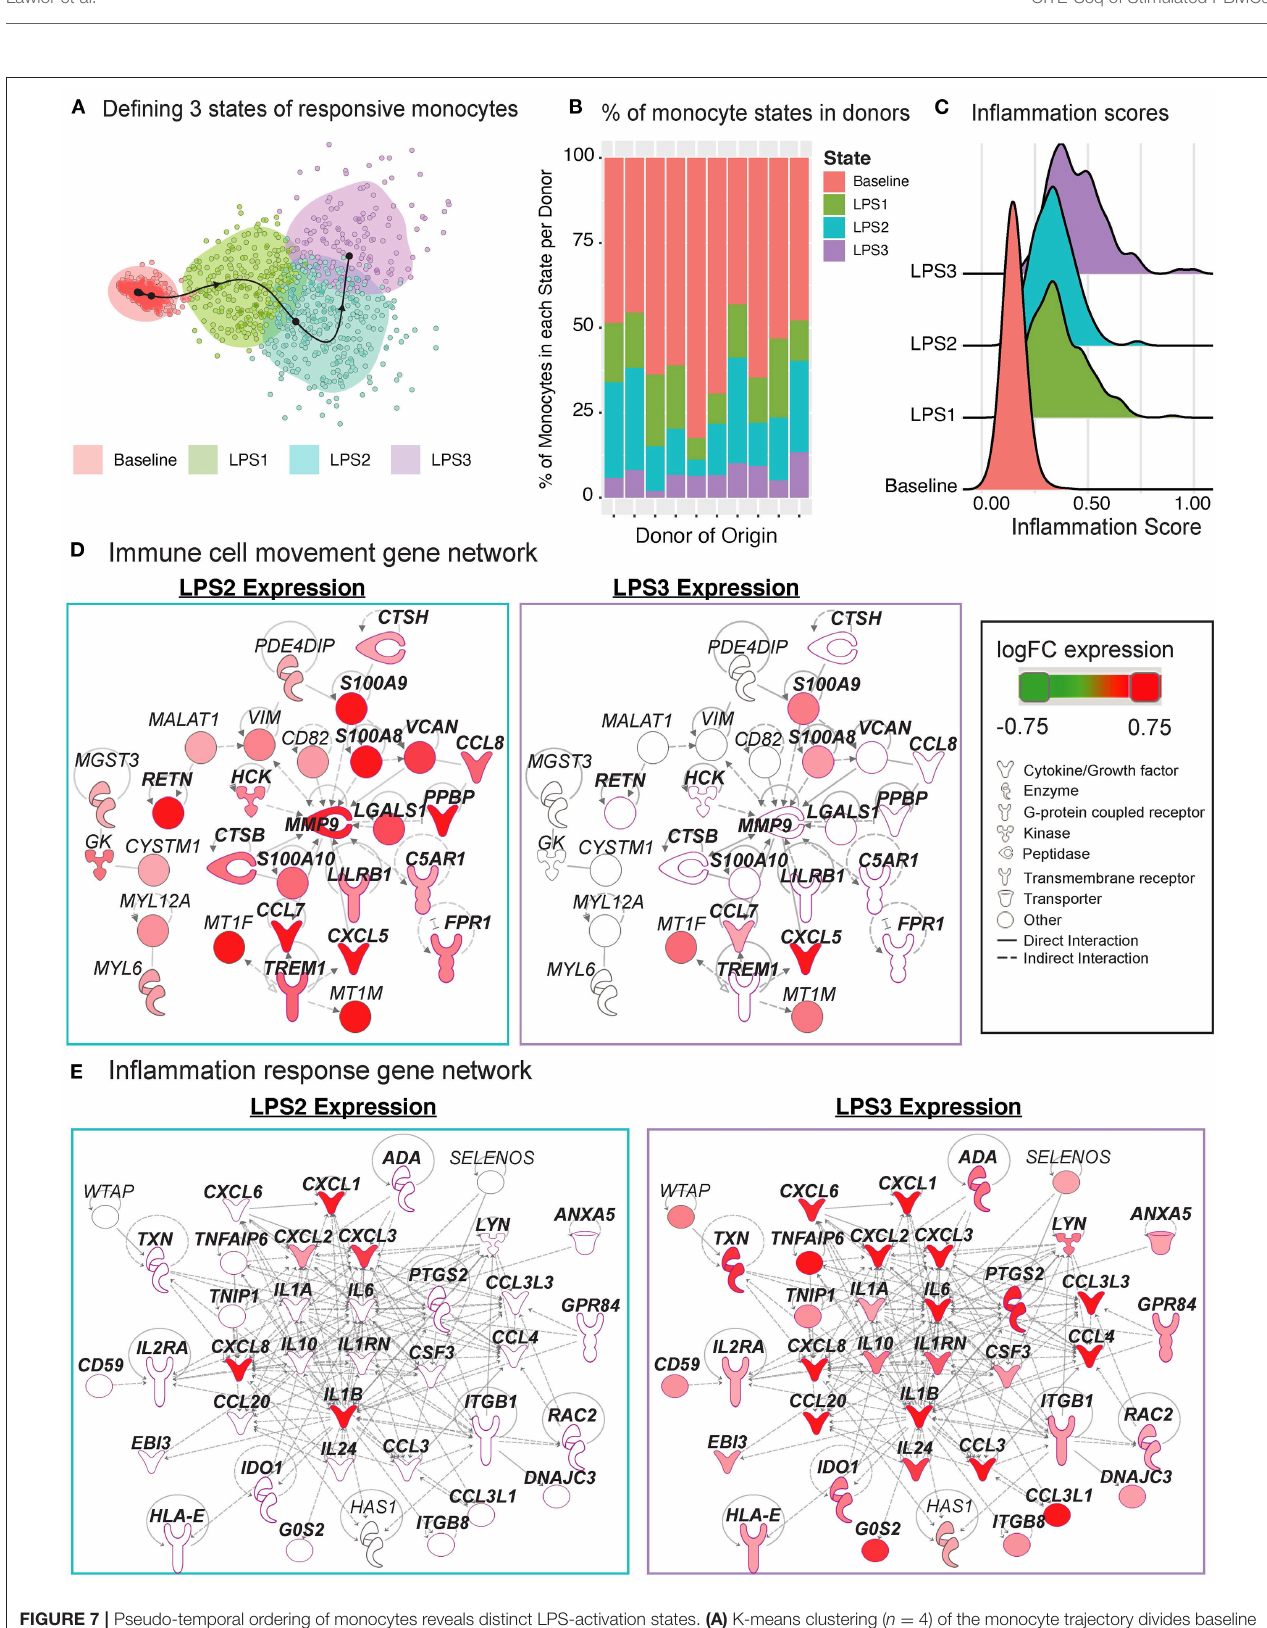
FIGURE 7 | Pseudo-temporal ordering of monocytes reveals distinct LPS-activation states. (A) K-means clustering ( n = 4) of the monocyte trajectory divides baseline cells into one group and activated cells into three groups (LPS1, LPS2, LPS3). (B) Proportions of monocytes found in each of the four states across the 10 donors.